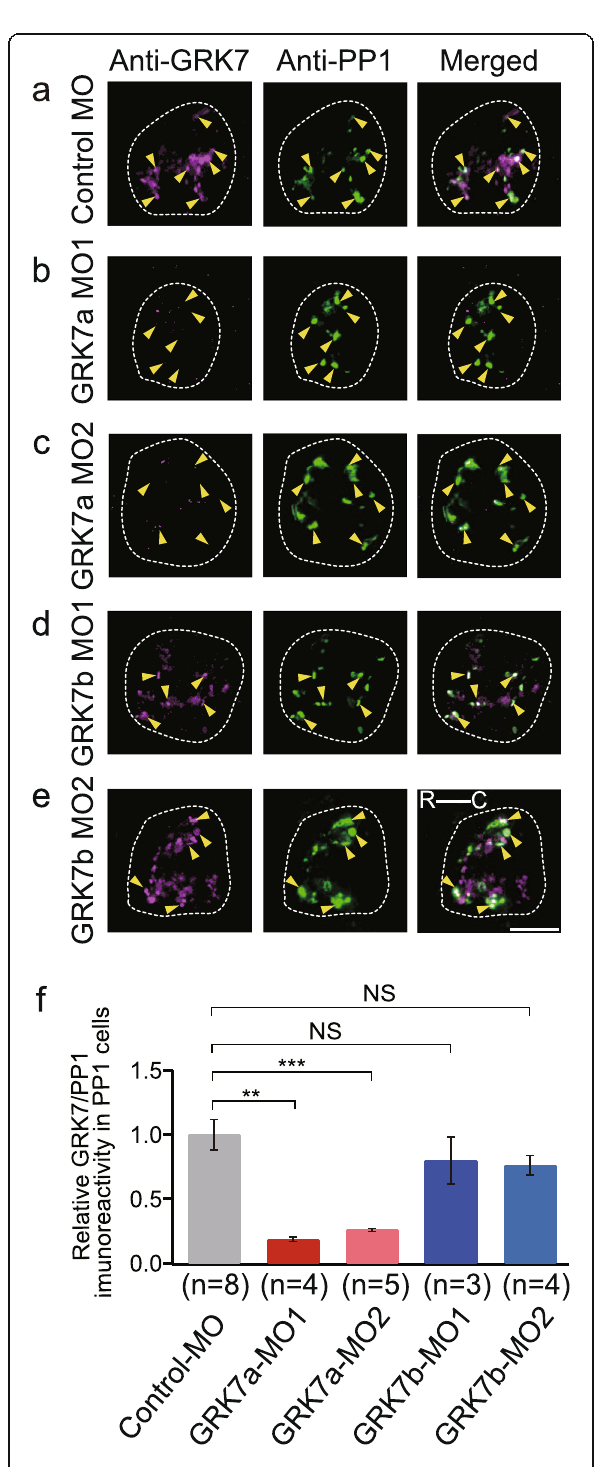
Fig. 4 Evaluation of the knockdown effect by immunohistochemistry using an anti-GRK7 antibody. Double immunostaining for GRK7 (magenta) and PP1 (green) in the knockdown zebrafish larvae. a Control MO knockdown, ( b ) GRK7a-MO1 knockdown, ( c ) GRK7a-MO2 knockdown, ( d ) GRK7b-MO1 knockdown and ( e ) GRK7b-MO2 knockdown. The white dotted traces indicate the landmarks of the pineal organ. The yellow arrowheads indicate PP1 cells in the pineal organ of larval zebrafish. The scale bar represents 25 μ m. The rostral (R) and caudal (C) sides are shown. f Quantitative analyses of GRK7 immunoreactivity in different GRK MO- or control MO-injected larvae. The ratios of GRK7 immunoreactivity to PP1 immunoreactivity in PP1 cells are compared. The error bars indicate the standard error. Significance scores represent P values determined by Wilcoxon